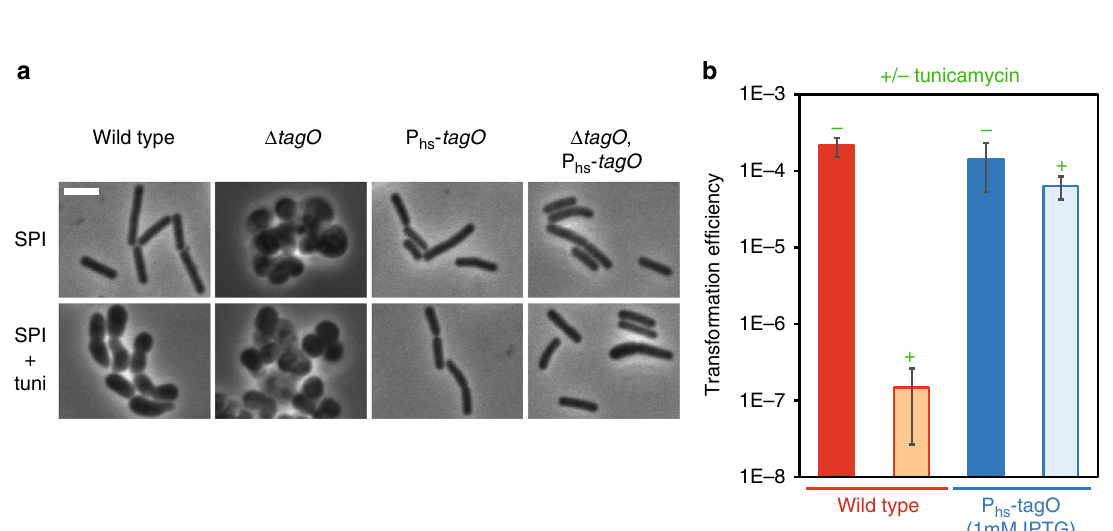
Fig. 2 Tunicamycin targets TagO to inhibit genetic transformation. a The P hs - tagO construct complements the morphological defects associated to either tagO deletion or addition of tunicamycin. Representative phase contrast images of cells of various genetic backgrounds (WT, strain 168; Δ tagO , strain NC227; P hs -t agO , strain NC228; Δ tagO P hs - tagO , strain NC229) exponentially growing in SPI (top panels) or in SPI supplemented with tunicamycin (0.31 µ g/ml, bottom panels). In the tagO null mutant (strain NC227), the absence of WTAs induces important morphological defects leading to